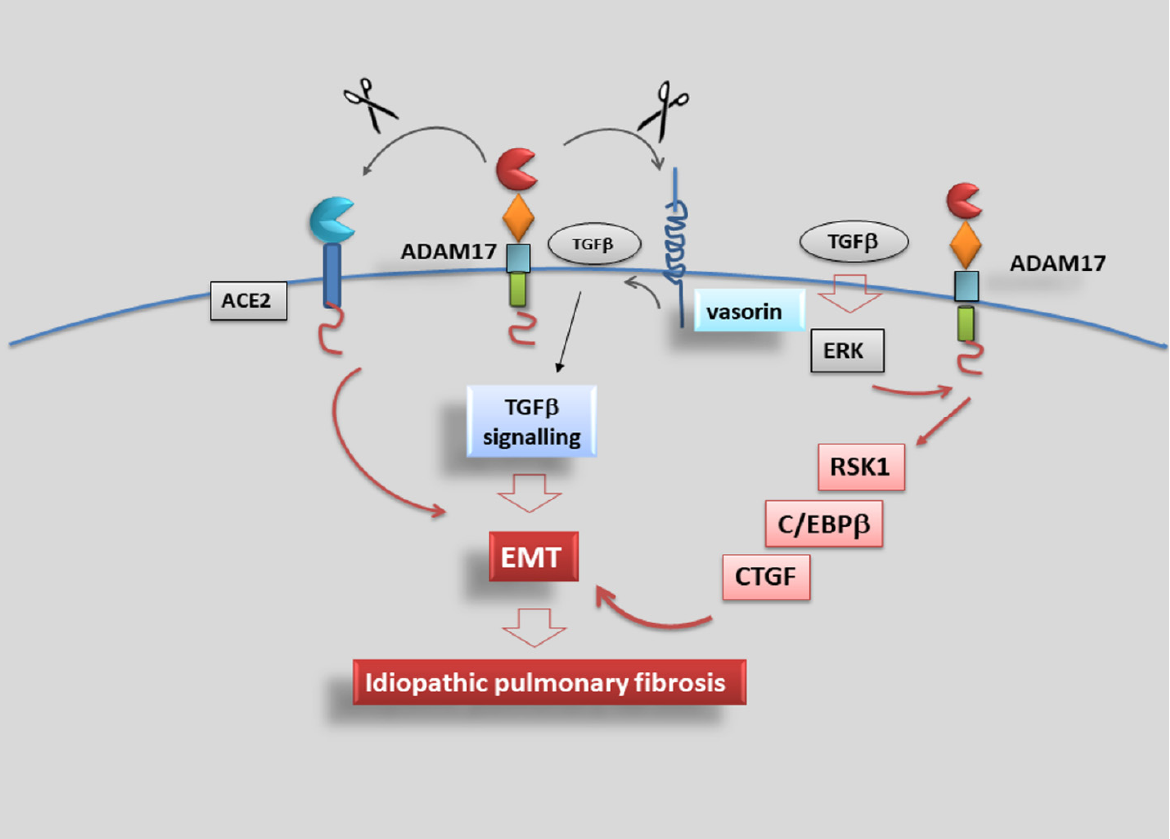
Figure 5. ADAM17 promotes idiopathic pulmonary fibrosis via EMT activation. Representative scheme illustrating the results of TGF- β -induced CTGF expression mediated via the ERK/ADAM17/RSK1/C/EBP β pathway in human lung epithelial cells. TGF- β activates the ERK/ADAM17/RSK1/C/EBP β signalling pathway, which finally leads to CTGF expression, promoting EMT in human lung epithelial cells. Table 1. Substrates of EMT pathways signalling activation in which ADAM17 has been implicated. Pathology Signalling